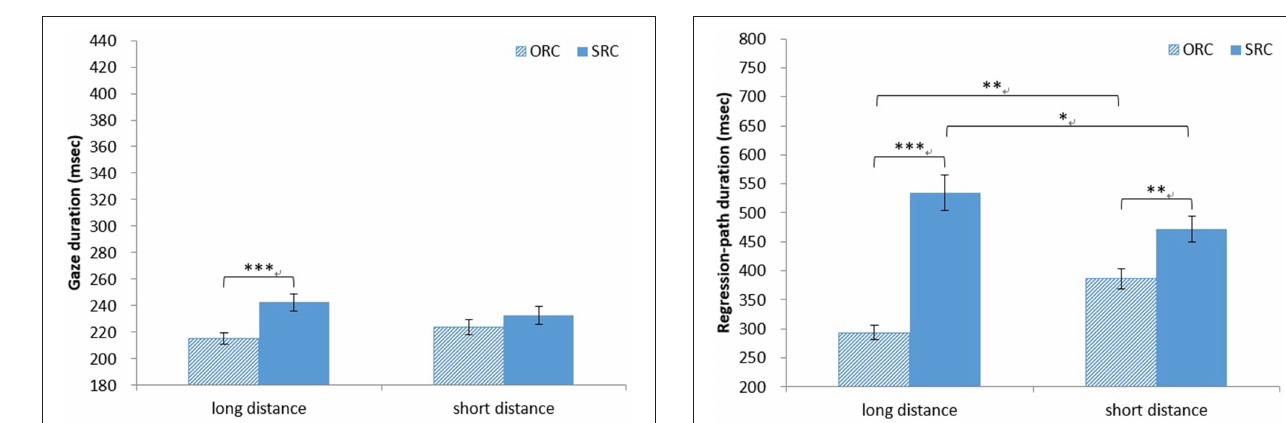
Regression rate. The main effect of clause type on regression rate was not significant (both ps > 0.10), as were the main effect of distance (both ps > 0.05) and the interaction between clause type and distance (both ps >